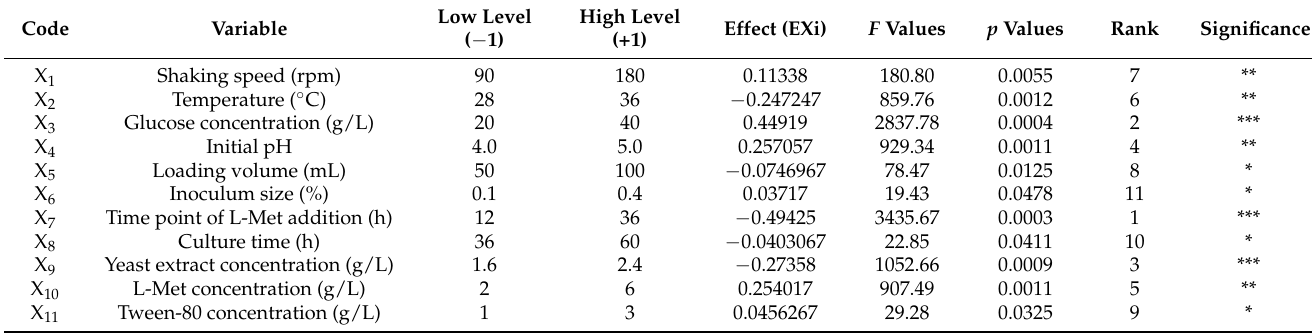
Table 2. Levels of the variables and statistical analysis in PB design for 3-Met production.